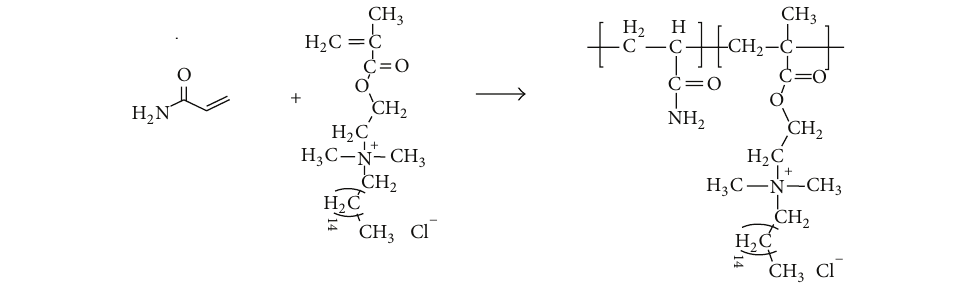
( 𝑐 𝑃 < 0.05 g dL −1 ), the apparent viscosity of copolymers is lower than that of PAM due to intramolecular association which leads to the coil of chain. This effect is enhanced by increasing either the 𝑁 𝐻 or the hydrophobe concen- tration. And it is well explained that the [𝜂] of all the poly(AM/DMDCC) is reduced compared to that of PAM and inverse to the 𝑁 𝐻 value. Because the [𝜂] of the polymer was determined by automatic capillary viscometer at low poly- mer concentration, intermolecular interaction was gradually enhanced with the increase in polymer concentration. Above a critical concentration, that is, CAC, an upward curvature in the apparent viscosity can be observed. The apparent viscosity increases more markedly and shows up at lower concentration with increasing the hydrophobic length at the same hydrophobe concentration. The CAC of 0.5DM4.5 and 0.5DM9.3 is 0.15 g dL −1 and 0.13 g dL −1 , respectively. On the other hand, 0.75DM9.3 and 0.5DM9.3 have the same hydrophobic microblock length; the increase in hydrophobe also enhances thickening efficiency. This behavior can